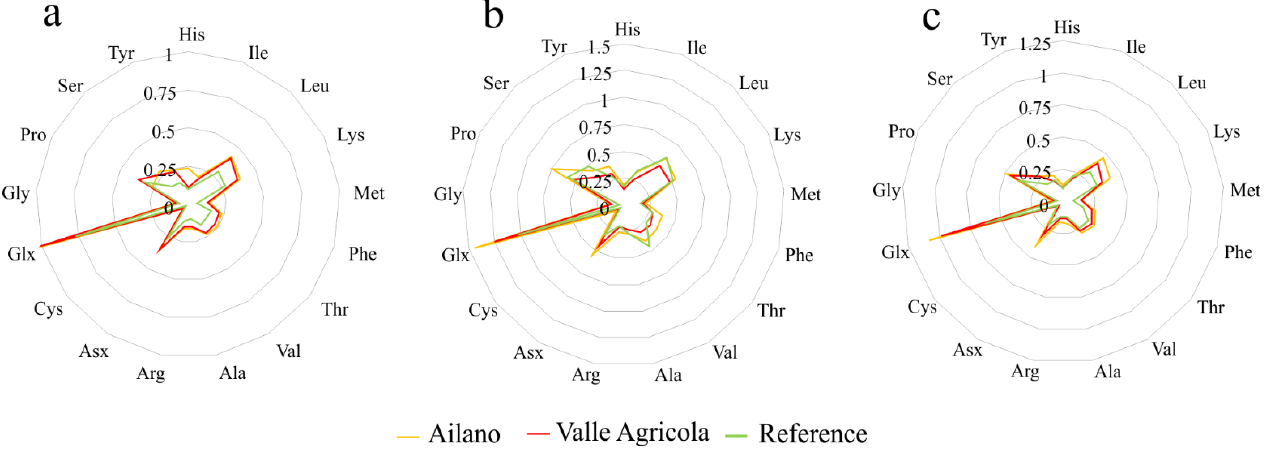
Figure 4. Radar graphs of the total amino acid content from the three types of milk analyzed, sampled in Ailano and Valle Agricola mountain localities, in comparison with the reference values [22]. ( a ) cow raw milk, ( b ) sheep raw milk and ( c ) goat raw milk.